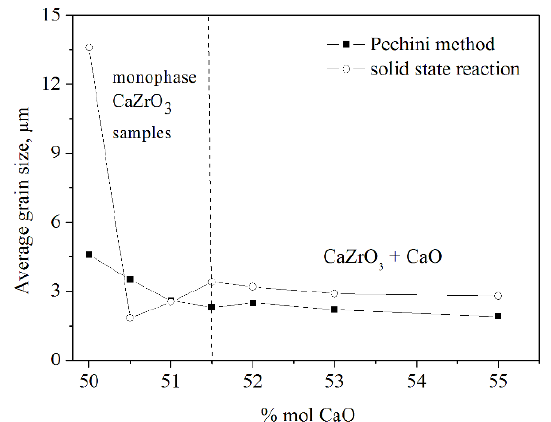
Figure 5. The variation of grain sizes of CaZrO obtained by Pechini method as well as solid-state